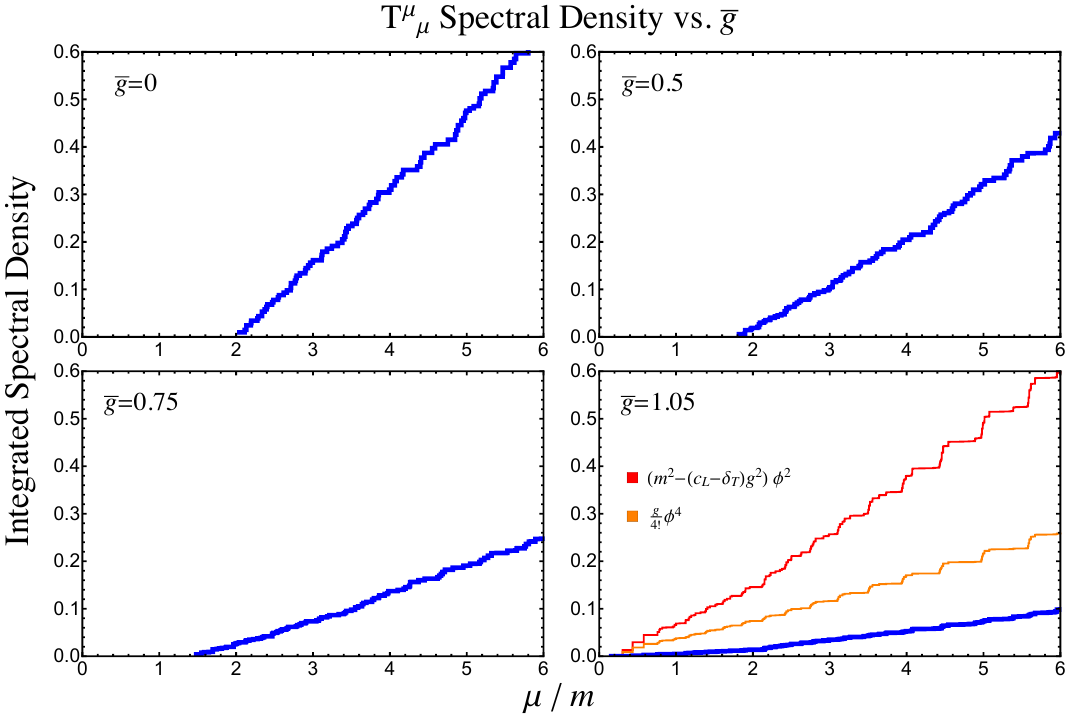
(blue), defined in (5.10), for different values of ¯ g µ = 16 and i = 65 , with ˆ δ 0 . 89 fixed by the max max T ≈